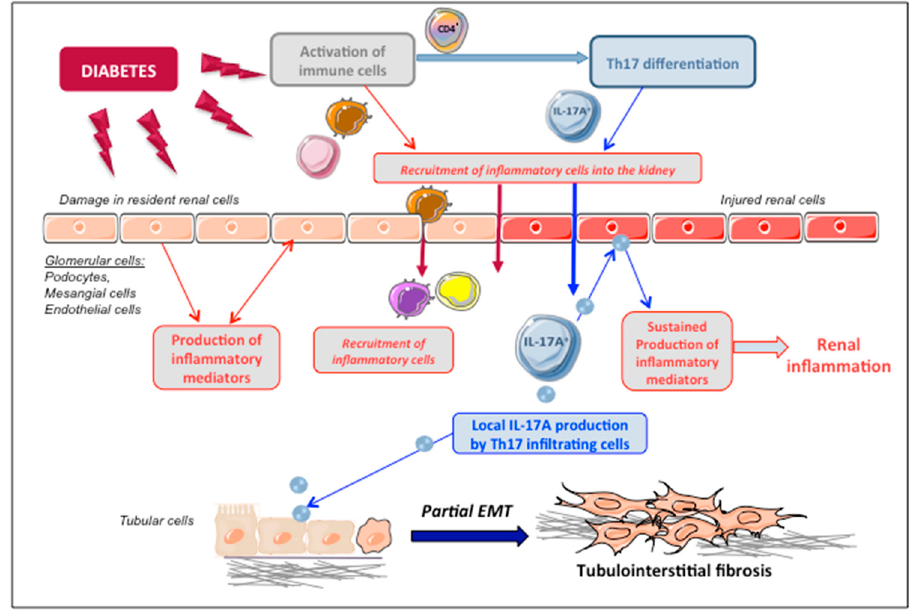
Figure 2. Proposed mechanism of IL-17A-induced renal damage in diabetic nephropathy. Under diabetic conditions, renal resident cells are activated and can produce different mediators that could contribute to recruit immune cells into the kidney. Infiltrating Th17 cells can locally produce IL-17A in the diabetic kidney. Then, IL-17A acting on IL-17R on resident renal cells can produce additional proinflammatory mediators, contributing to sustained inflammation. Moreover, IL-17A acting on tubular epithelial cells can induce phenotype changes, such as partial epithelial-to-mesenchymal transition (EMT) and secretome changes. By these mechanisms, IL-17A participates in the